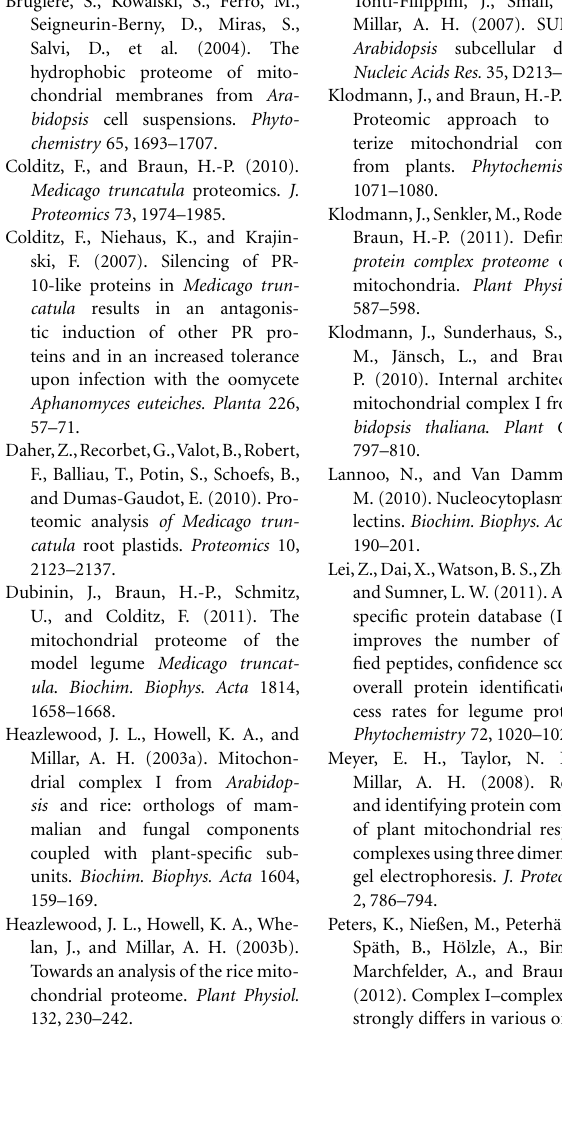
Figure S2 | Mitochondria protein complexes of M. truncatula resolved by 2D blue native/SDS PAGE.